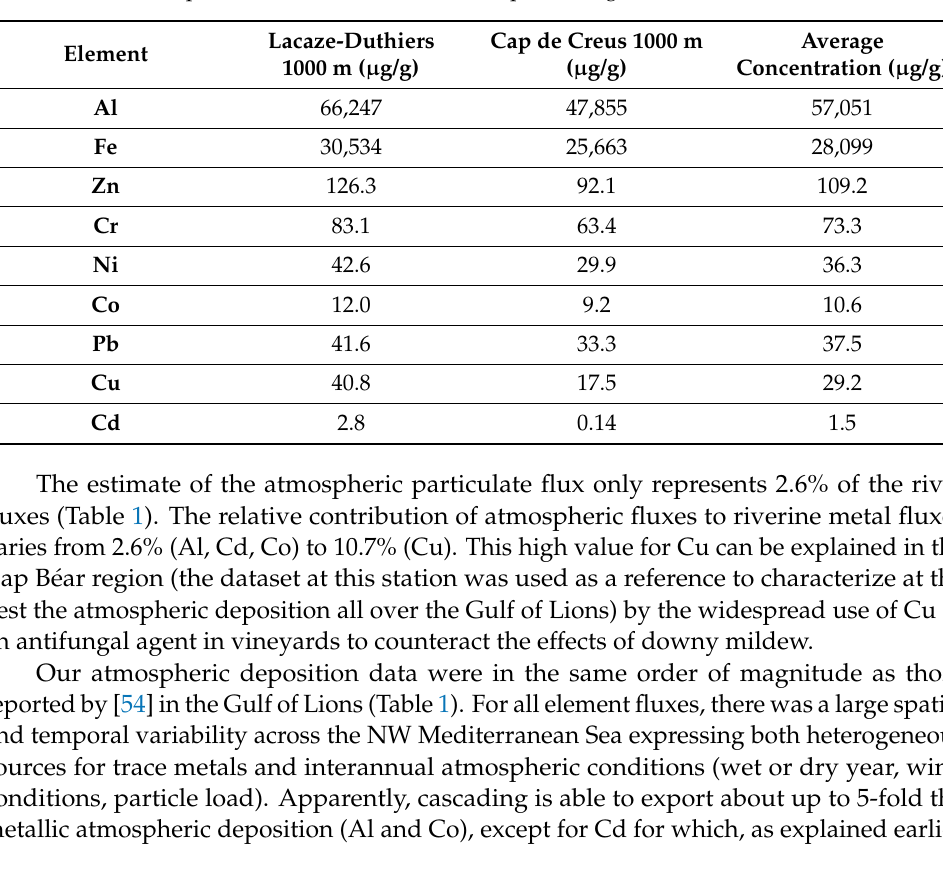
Table 2. PTM concentration in the Lacaze-Duthiers Canyon, Cap de Creus Canyon, and average concentration of the particulate matter at a 1000 m depth during the winter of